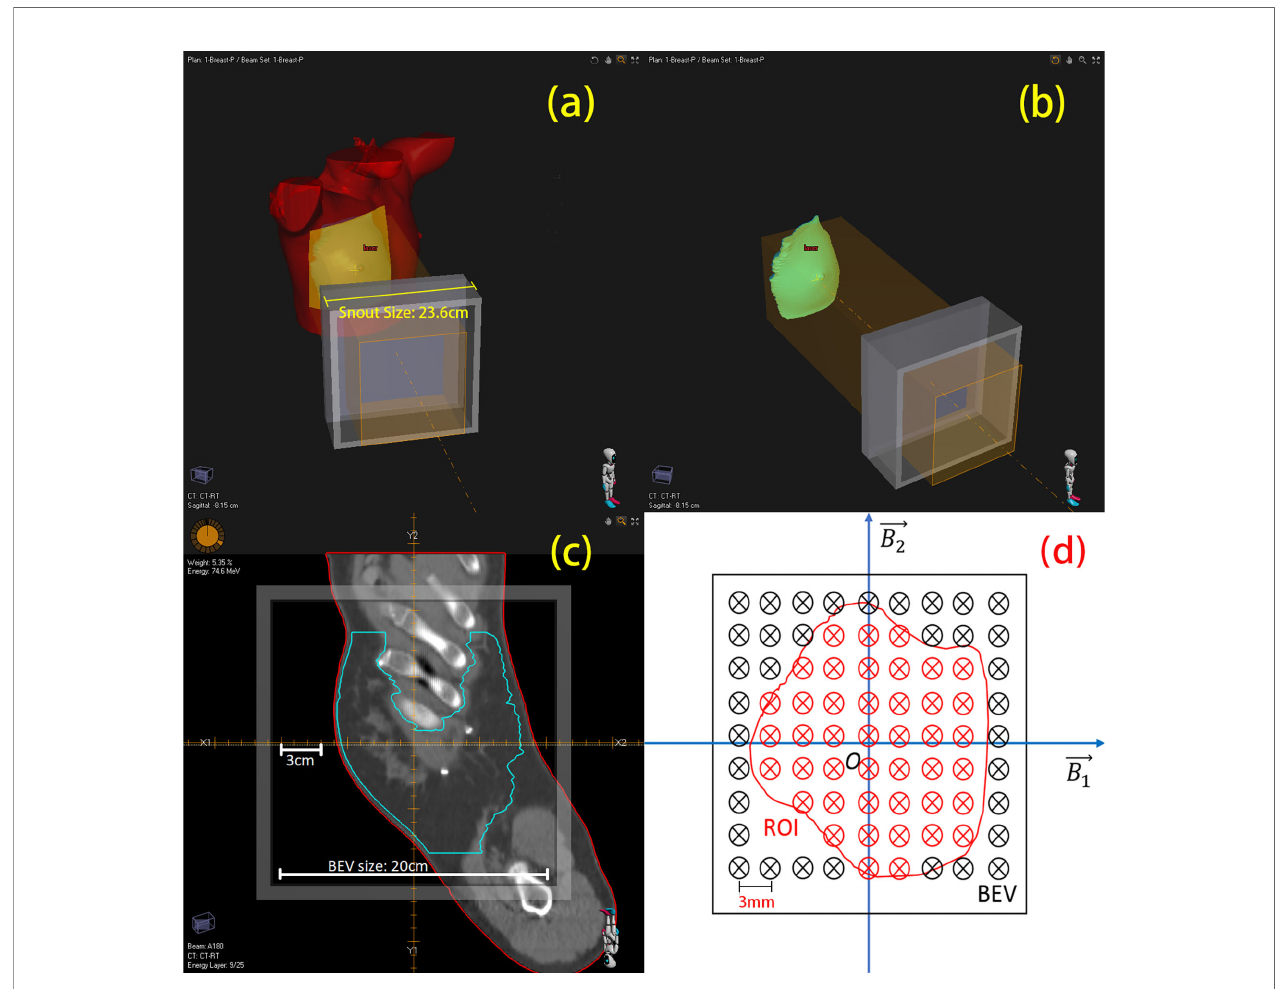
FIGURE 1 | 3-D view of region of interest (ROI) and mapping to BEV (beam ’ s eye view). (A) A single beam irradiates to the patient ’ s breast. (B) Irradiating to the patient CTV. (C) One slice image of CTV on BEV. (D) Sketch of scoring lines inside (red) and outside (black) the ROI; scoring line interval is 3